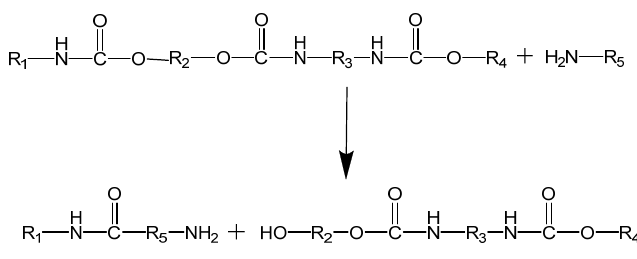
Scheme 6. Reaction scheme of the aminolysis of PU.